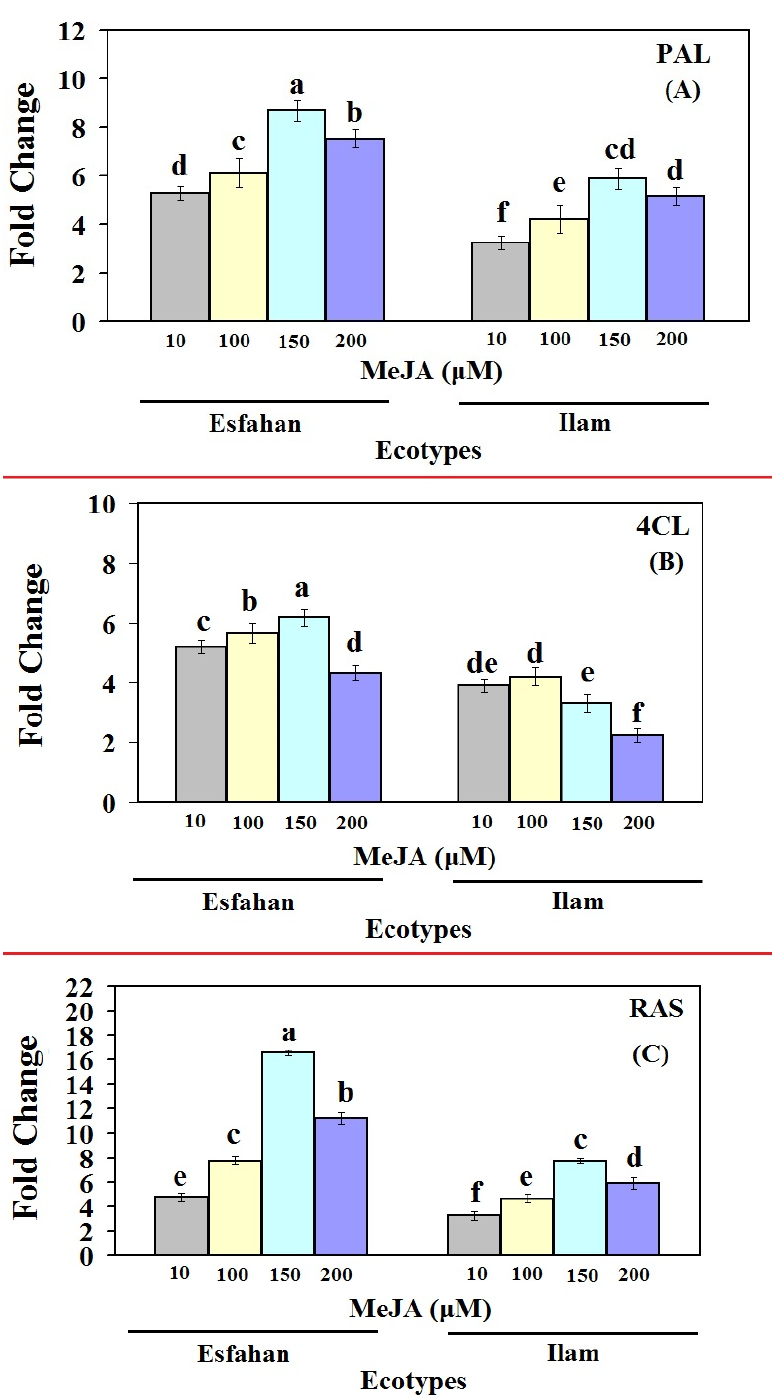
Figure 4. Gene expression (Fold-change) of first, middle and late pathway genes of rosmarinic acid biosynthesis pathway, PAL ( A ), 4CL ( B ) and RAS ( C ), in leaves of control (untreated) and MeJA- treated lemon balm plants. qRT-PCR was based on the Ct values. The Ct value for each sample was normalized using the reference gene β -Actin . Bars with different letters are significantly ( p ≤ 0.01) different according to Duncan’s test. Error bars indicate standard error